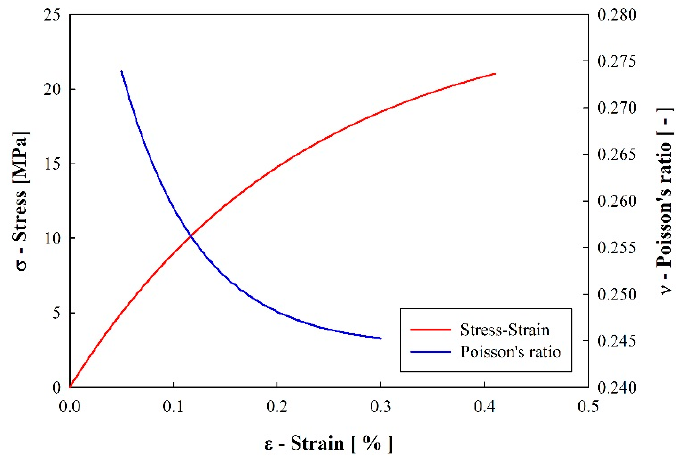
Figure 4. Average results of experimental tensile testing.